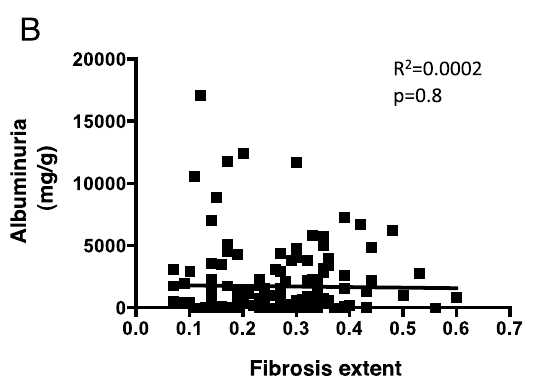
Figure S1 Distribution of proteinuria in the 162 CKD patients. A,B,C. Best-fit slope of linear regression between a 1MG and RBP (A), TRF and RBP (B), and proteinuria and RBP (C). D, E, F, G. Histograms showing TRF (D), a 1MG (E), b 2MG (F) and total proteinuria (G) values according to the type of kidney disease. Protein concentrations are expressed as mean 6 sem. *p , 0.05, **p , 0.01, ***p , 0.001, compared to glomerular disease, Student T test, except Mann-Whitney test for Glomerular vs Non specific comparison and ANOVA for (G). Glom = glomerular disease; Tub-Int= tubular and interstitial diseases; Vasc = vascular diseases; Non-spe = non-specific lesions. (EPS) Figure S2 Distribution of proteinuria according to estimated glomerular filtration rates. Histograms showing a 1MG (A), b 2MG (B), IgG (C) and TRF (D) values according to the type of kidney disease. Protein concentrations expressed as mean 6 sem. *p , 0.05, **p , 0.01, ***p , 0.001, as compared to eGFR , 30 ml/min. (EPS) Figure S3 Correlation between proteinuria and the extent of interstitial fibrosis. Best-fit slopes of linear regression between a 1MG (A), b 2MG (B), TRF (C), IgG (D), and proteinuria (E) and the extent of interstitial fibrosis. (EPS) Figure S4 Correlation between proteinuria and the extent of interstitial fibrosis according to the type of nephropathy. Best-fit slope of linear regression between fibrosis extent and RBP according to the type of nephropathy: glomerular (A), tubular (B), and vascular (C). (EPS)